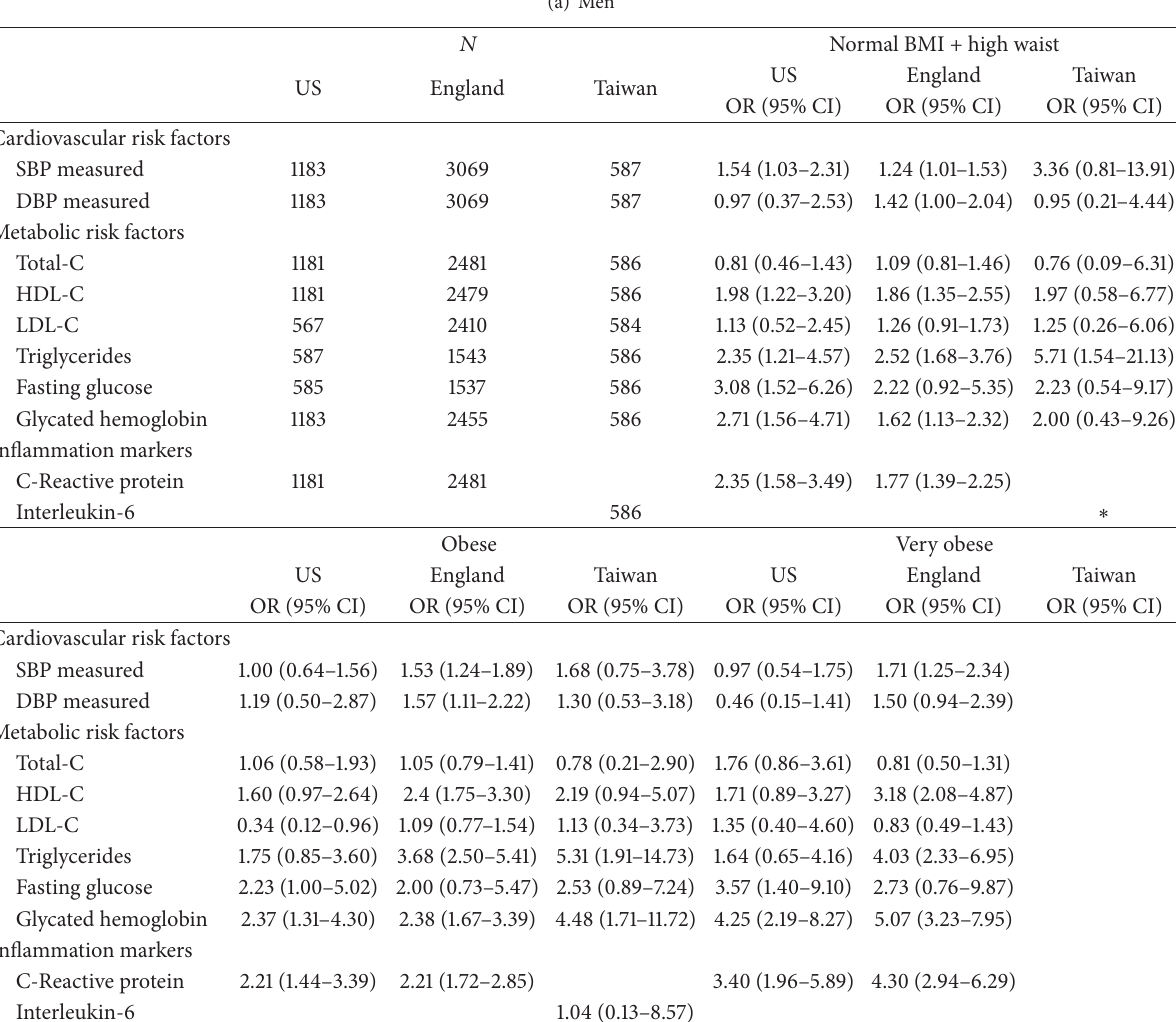
Table 3: Odds ratios from logistic regression models predicting at-risk levels of biomarkers by BMI and waist circumference groups (normal BMI and high waist, obese, and very obese) among American, English, and Taiwanese aged